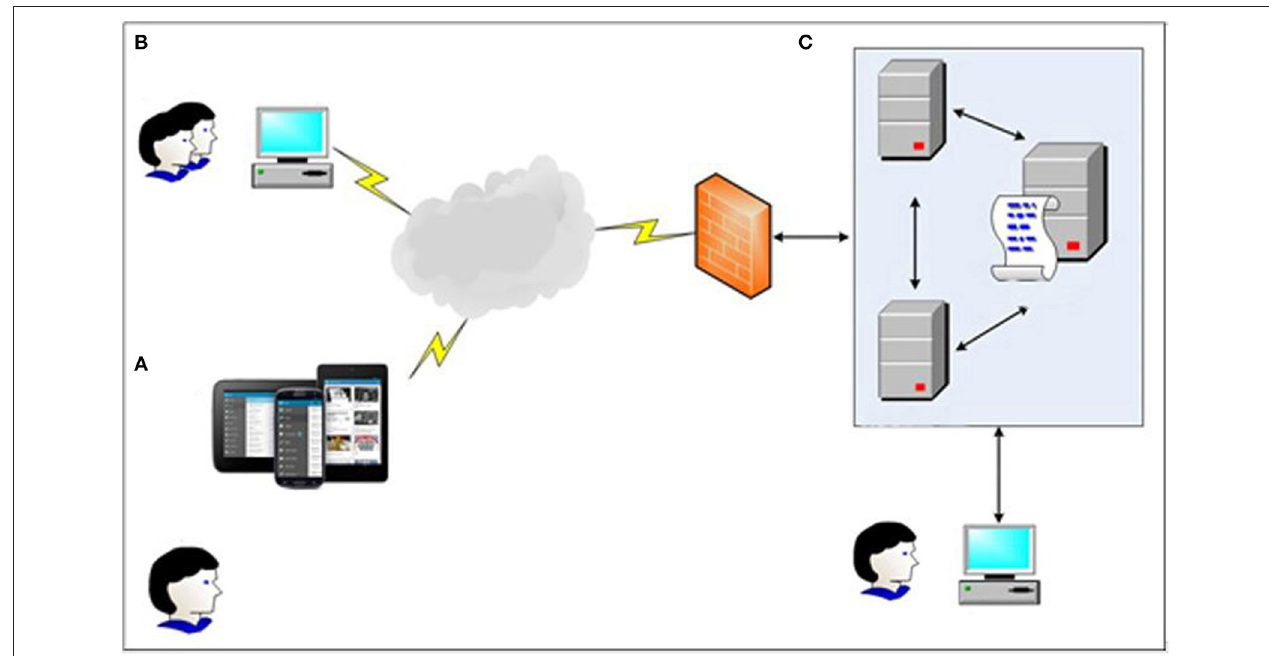
FIGURE 1 | Frame diagram of Community-based Addiction Rehabilitation Electronic System (CAREs): (A) Users manage to get immediate support and intervention through CAREs installed in smart phone devices; (B) Users’ corresponding social workers can know their clients’ current situation by using the web page; (C) All data will be stored in a secure server and double backuped, only doctors and executives are eligible for access.